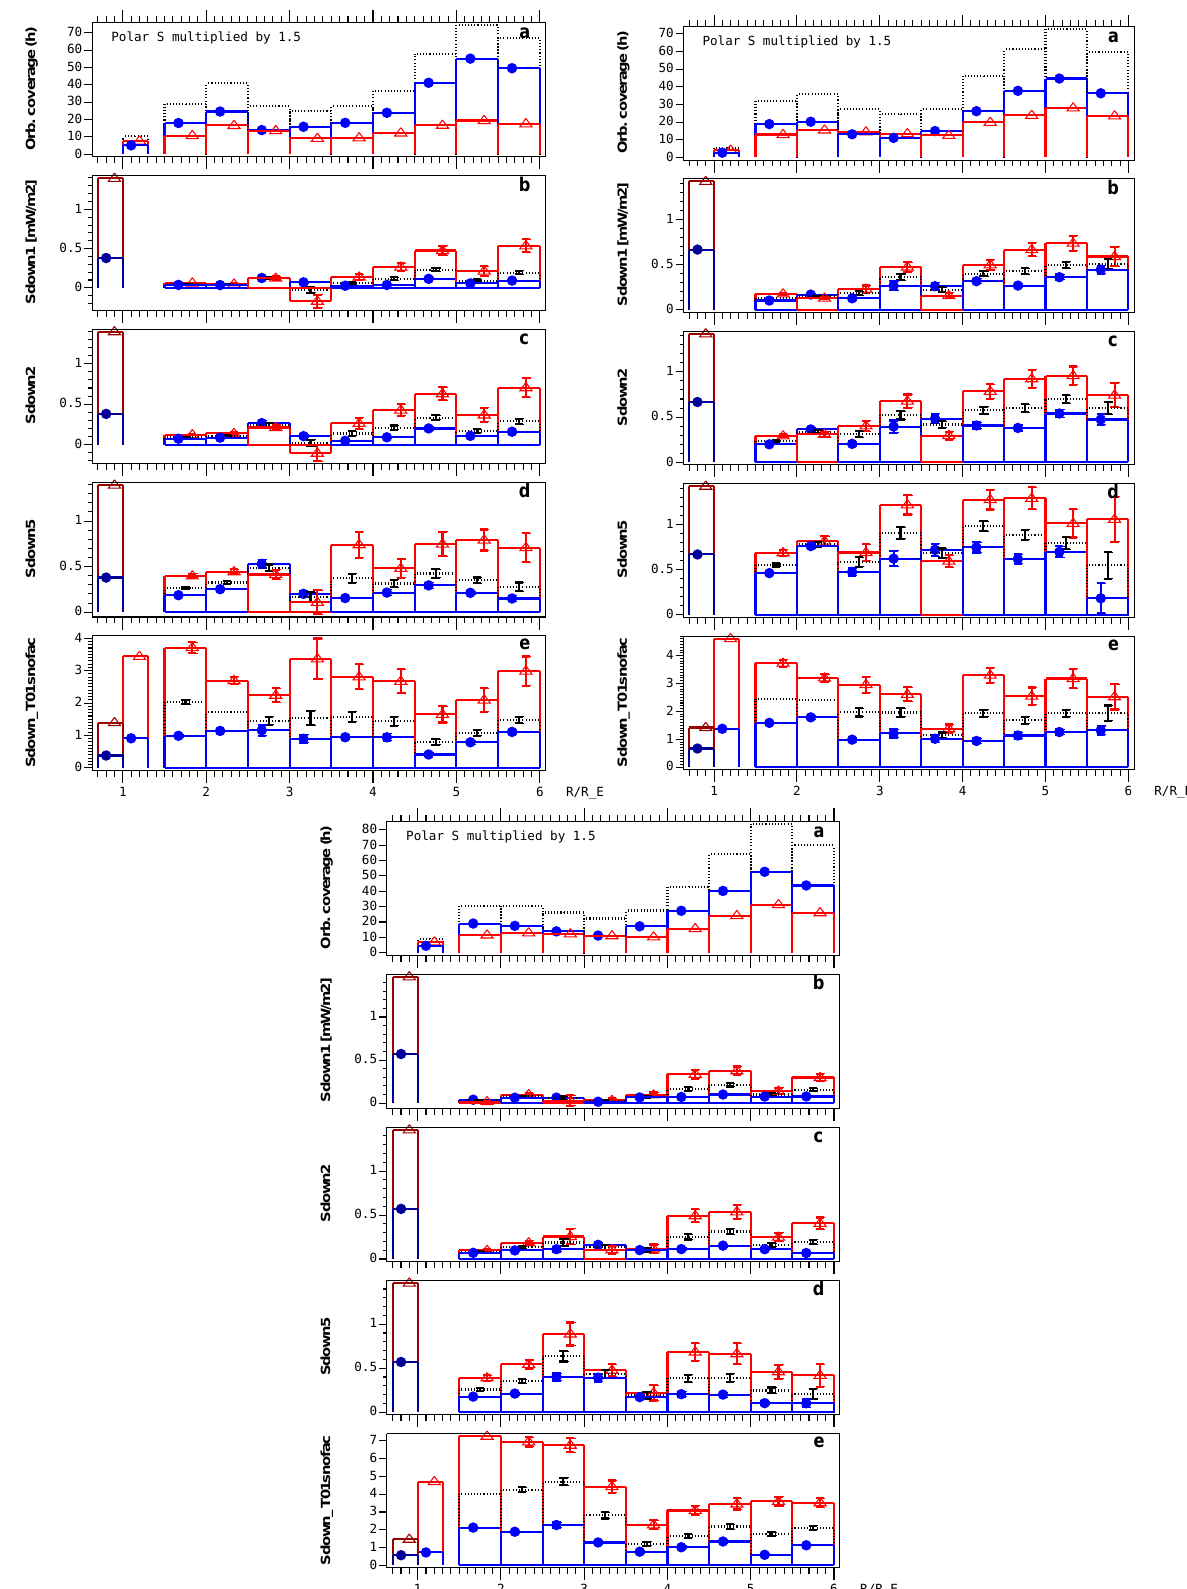
Fig. 5. Same as Fig. 2, but decomposed into three nightside MLT sectors, 18–22, 22–02 and